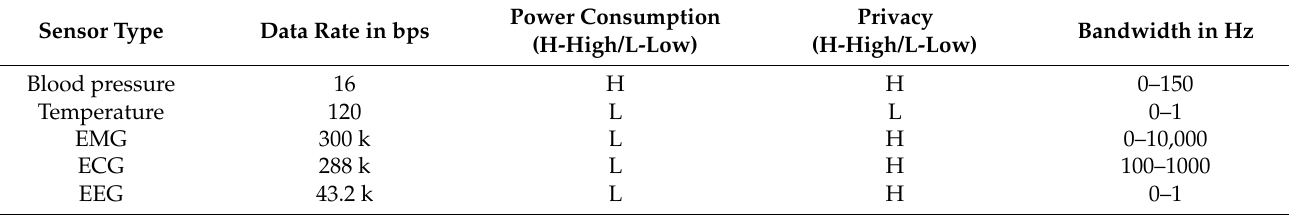
Table 1. Comparison of various sensors.